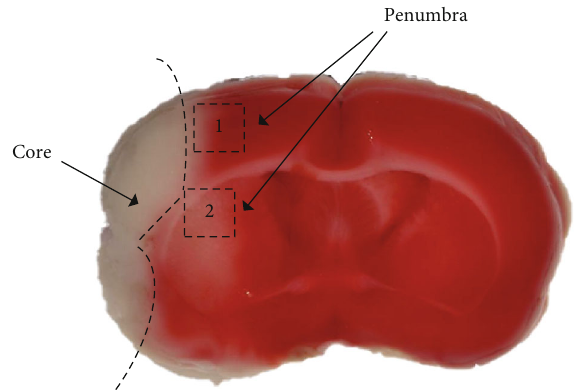
Figure 1: The penumbra and infarct core in rats after MCAO. The penumbra in the cortex was indicated with the black dashed box marked “ 1, ” and the striatum was marked “ 2, ” which were selected as the cortex and striatum for immuno fl uorescence staining and immunohistochemistry. Penumbra tissue was also used for qRT-PCR, Luminex multiplex assay, and western blotting.